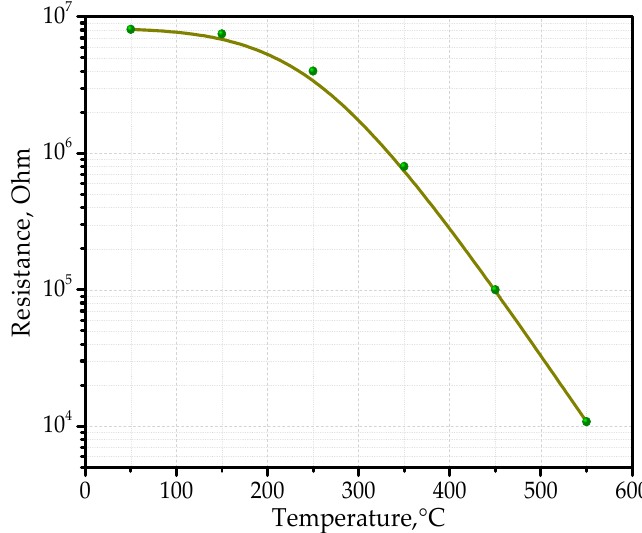
Figure 9. Curve showing the variation of the resistance of the Sn x Bi k Mo y O z sensitive layer to gas in air as a function of temperature.